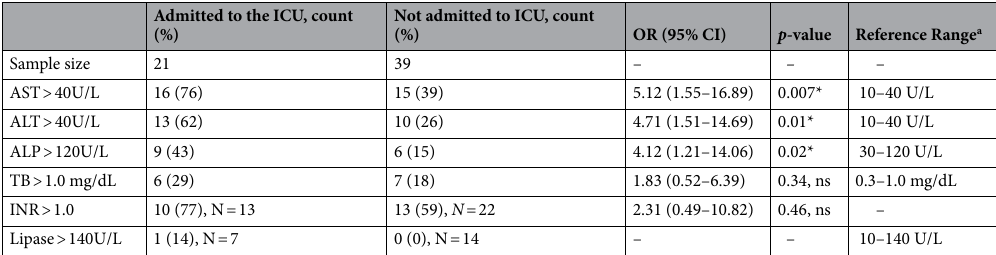
Table 1. Relationship of elevated hepatobiliary laboratory markers at any time during hospital admission and need for admission to the ICU. A Fishers Exact test was used to make comparisons, with p < 0.05 indicating statistical significance. Data are presented as count (percentage of total sample size, N ). An *implies a significant result. Sample sizes are indicated next to the data point if different from the main group heading. ALT alanine aminotransferase, ALP alkaline phosphatase, AST aspartate aminotransferase, CI confidence interval, ICU intensive care unit, INR international normalized ratio, ns non-significant, SEM standard error of the mean, TB total bilirubin. a Obtained from the ABIM Laboratory Test Reference Range datasheet, https:// www. abim. org/ ~/ media/ ABIM% 20Pub lic/ Files/ pdf/ exam/ labor atory- refer ence- ranges.p.